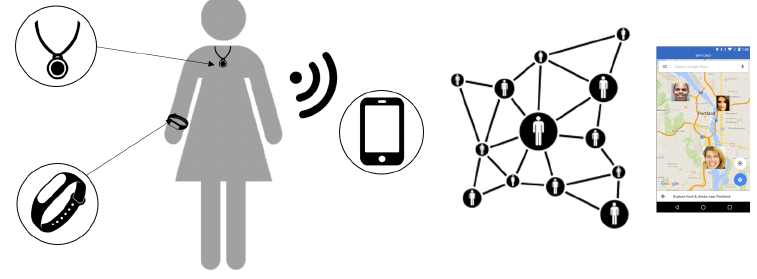
Figure 1. Conceptualization of the Bindi